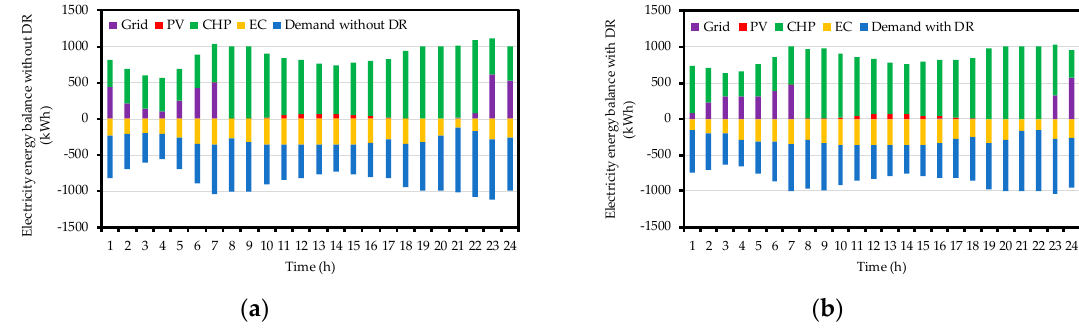
Figure 8. Optimal scheduling results for electricity: ( a ) without DR; ( b ) with DR.